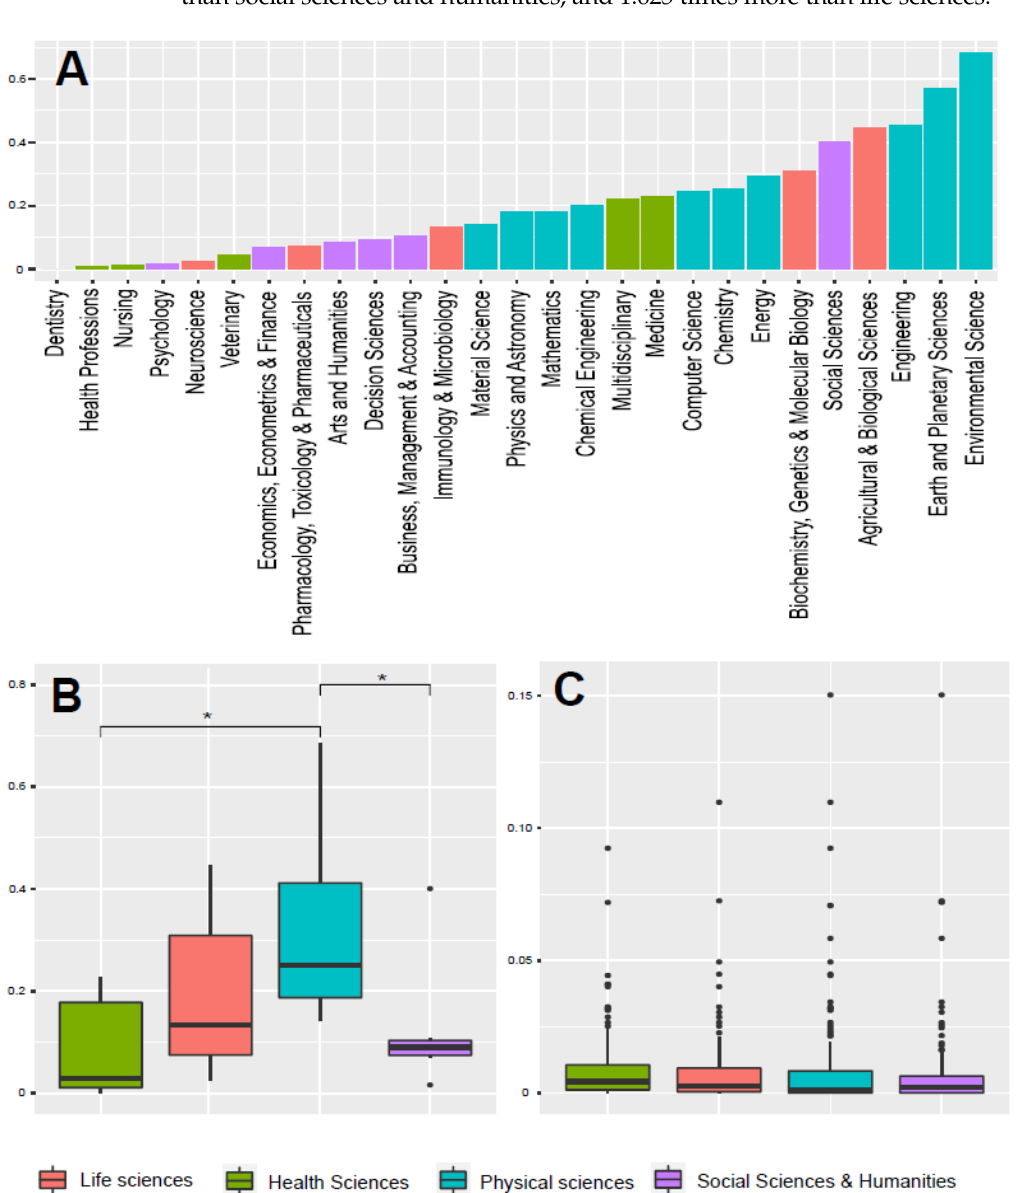
Figure 4. ( A ) Aggregated Jaccard similarities per “Subject Area” for the whole dataset ranging from 1972–2020. Showing the total interdisciplinarity per “Subject Area”. Colors denote the affiliation to scientific disciplines. ( B ) Boxplots of the aggregated Jaccard similarity per discipline (Table S1) for the complete time span. ( C ) Boxplots of the Jaccard similarity per “Classifications” per discipline. Significant differences are marked with an asterisk and denote a p-value of less than 0.05.